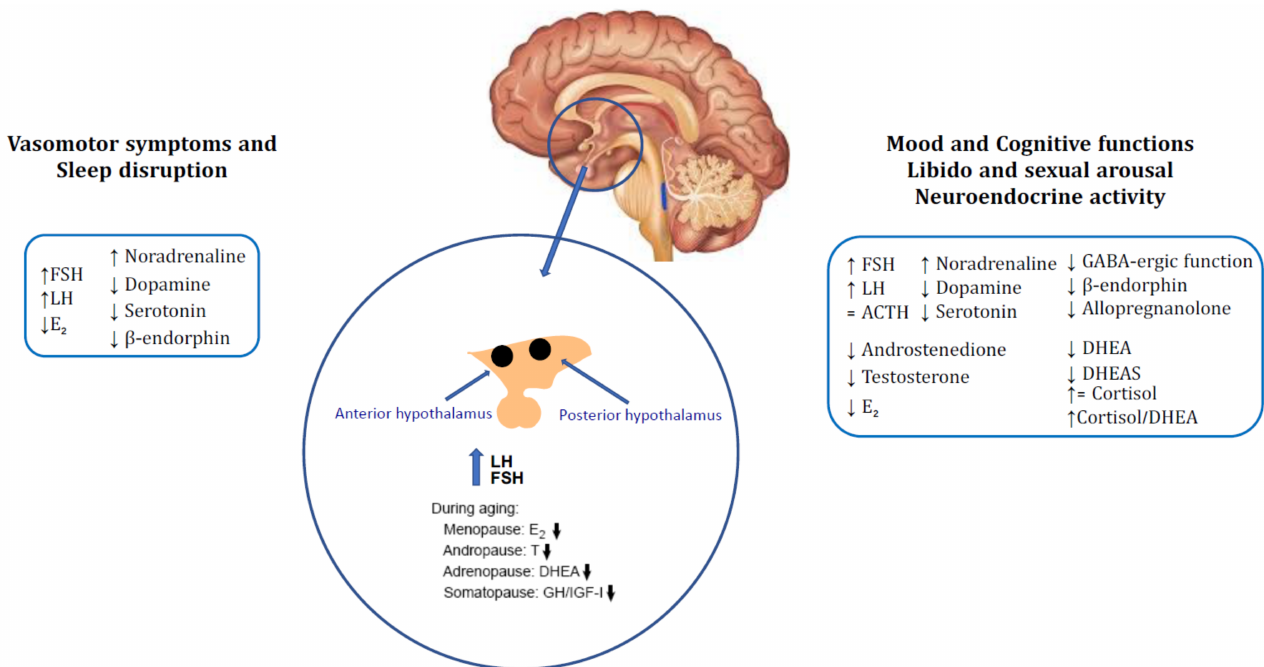
Figure 1. Brain neuroendocrine changes of menopause and the related symptoms: Modifications of gonadotropins, E2, neuromodulators and opioid tone in the hypothalamus causing onset of vasomotor symptoms and consequent sleep disruption. Mood, cognitive functions, libido, sexual arousal and neuroendocrine activity are close related to the impairment of GABAergic, opioid and neurosteroid milieu in central nervous system (CNS) occurred with ageing. Menopausal condition determines reduction in estrogens and ovarian and adrenal steroids (testosterone, androstenedione, DHEA and DHEA-S) which results in increase cortisol/DHEA ratio leading to sexual, mood and cognitive dysfunctions. ↑ : increased, ↓ : decreased, =: